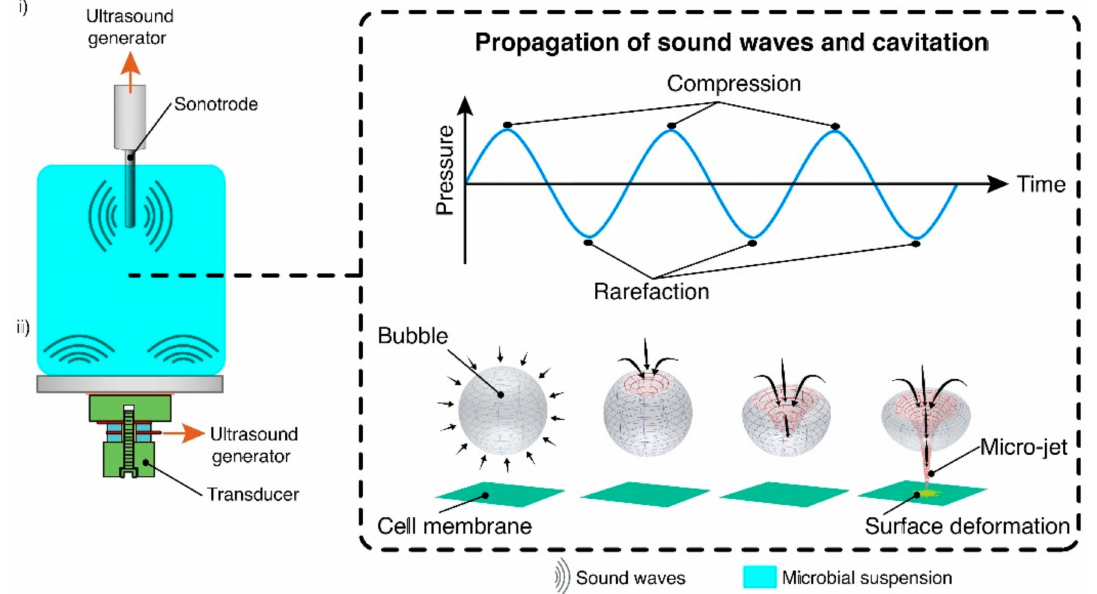
Figure 3. Schematic presentation of the formation of micro-jets through the collapse of acoustic cavitation bubbles. ( i ) Ultrasonic probe-based system, ( ii ) Ultrasonic transducer-based system (ultrasonic bath). Reprinted from